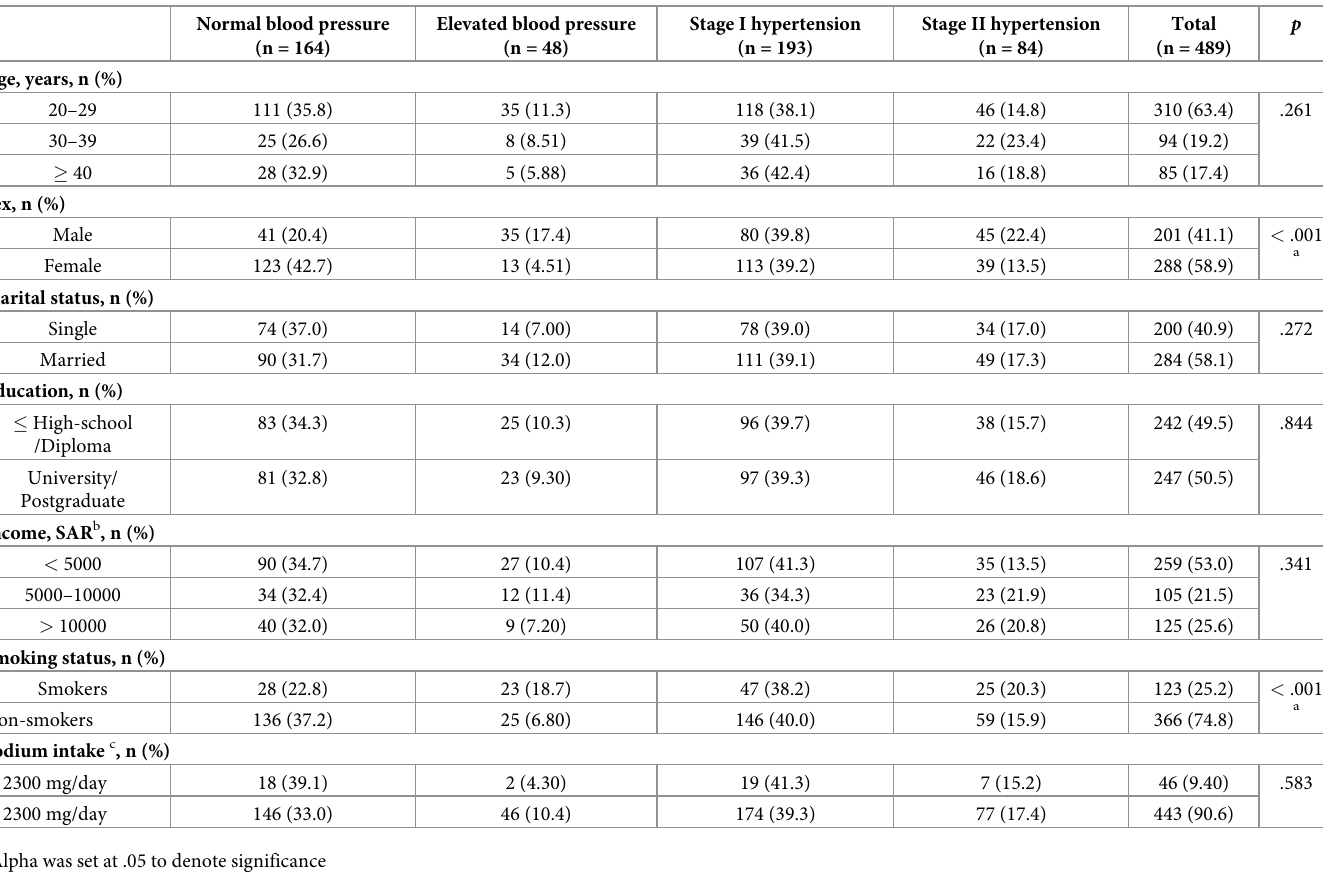
Table 1. Sociodemographic and health-related characteristics of participants stratified by blood pressure status (n = 489).